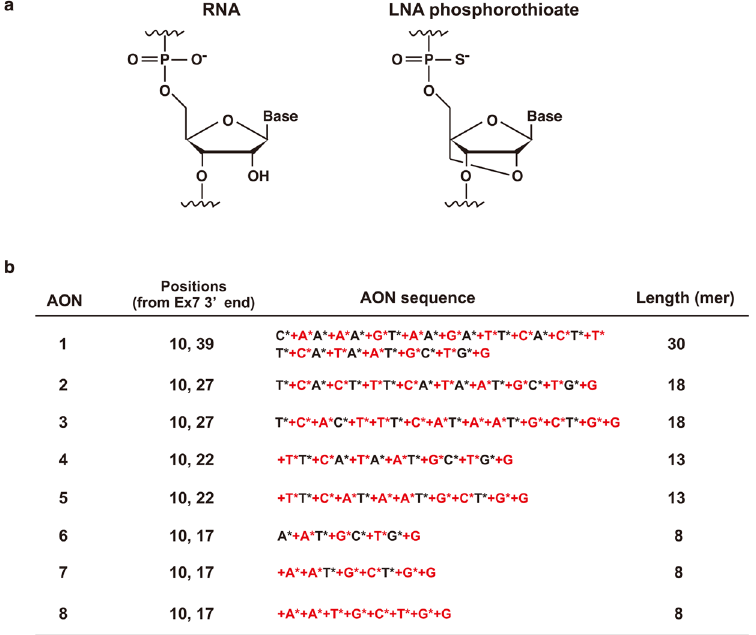
Figure 1. LNA structure and LNA/DNA mixmer sequences. ( a ) Chemical structures of RNA and phosphorothioated LNA. ( b ) LNA/DNA mixmer sequences targeting SMN2 intron 7. DNA base: G, A, T, C. LNA base (red): + G, + A, + T, + C. Phosphorothioated DNA base: G * , A * , T * , C * . Phosphorothioated LNA base (red): + G * , + A * , + T * , + C *